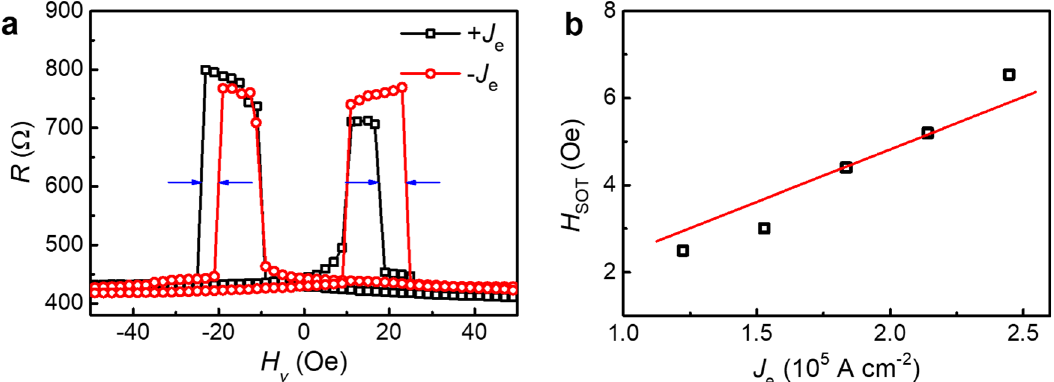
Fig. 3 SOT-induced shift of the magnetic switching fi eld. a R - H y curves measured under the opposite bias SOT current ± J e between T1 and T2, where the shift of the magnetic switching fi eld of B-CoFeB indicates the SOT-induced effective fi eld H c2 shift = ( H c2 + shift + H c2 − shift )/2 = H SOT ( + J e ) − H SOT ( − J e ) = 2 H SOT ( J e ). b H SOT as a function of the bias SOT current J e , where the linear dependence shows the typical SOT